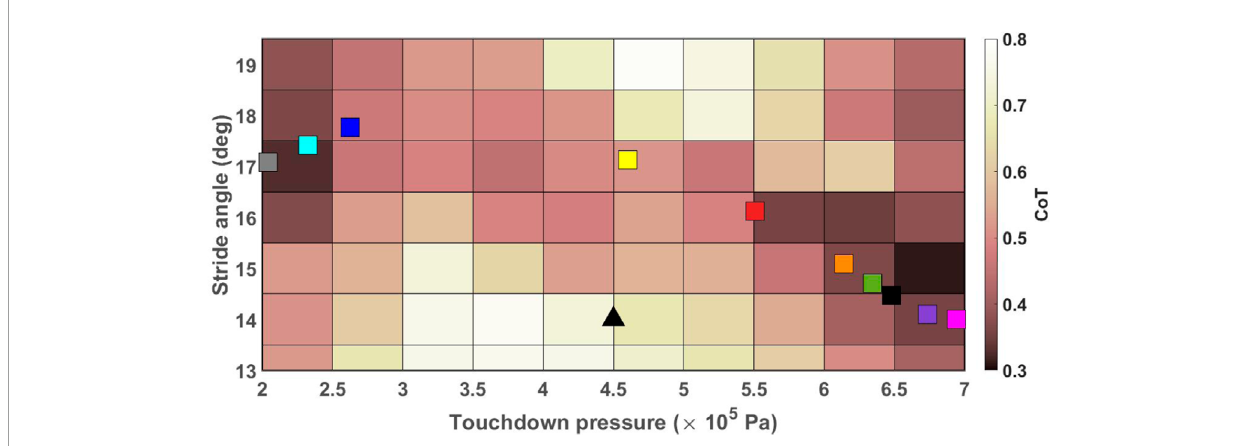
FIGURE 7 CoT values of the robot trotting on flat ground with ω = 105 deg/s as a function of P td and r . The colored squares show the end point of each run. All runs started from the black triangle.